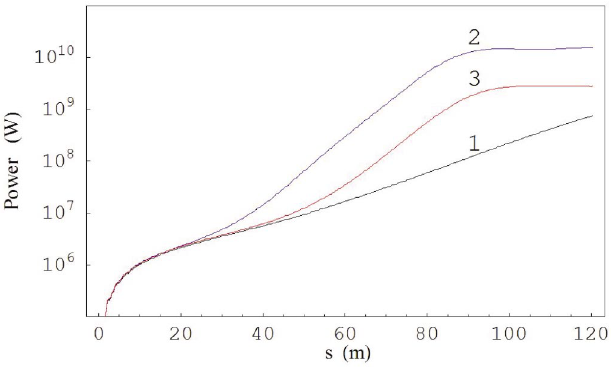
FIG. 9. (Color) The average x-ray power versus distance for an electron beam with 2.4 mm-mrad normalized emittance: 1 is the case without conditioning, 2 is the case of an ideal conditioning, and 3 is the case of a practical conditioning with a proposed